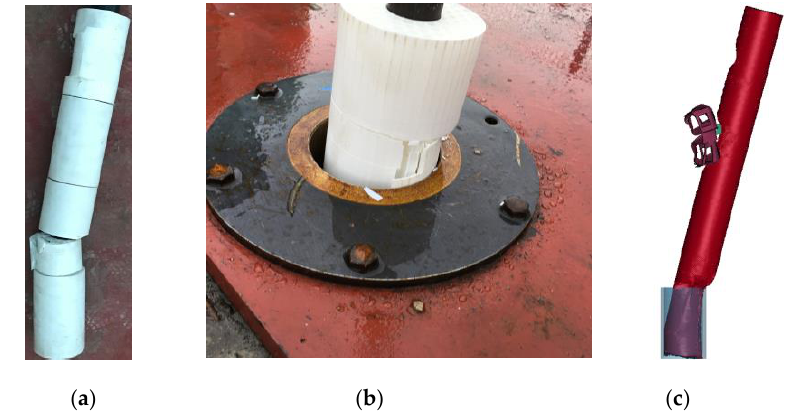
Figure 21. Damaged honeycomb bollard pictures: ( a ) Honeycomb unit damage; ( b ) Internal pipe deformation; ( c ) Simulation results.